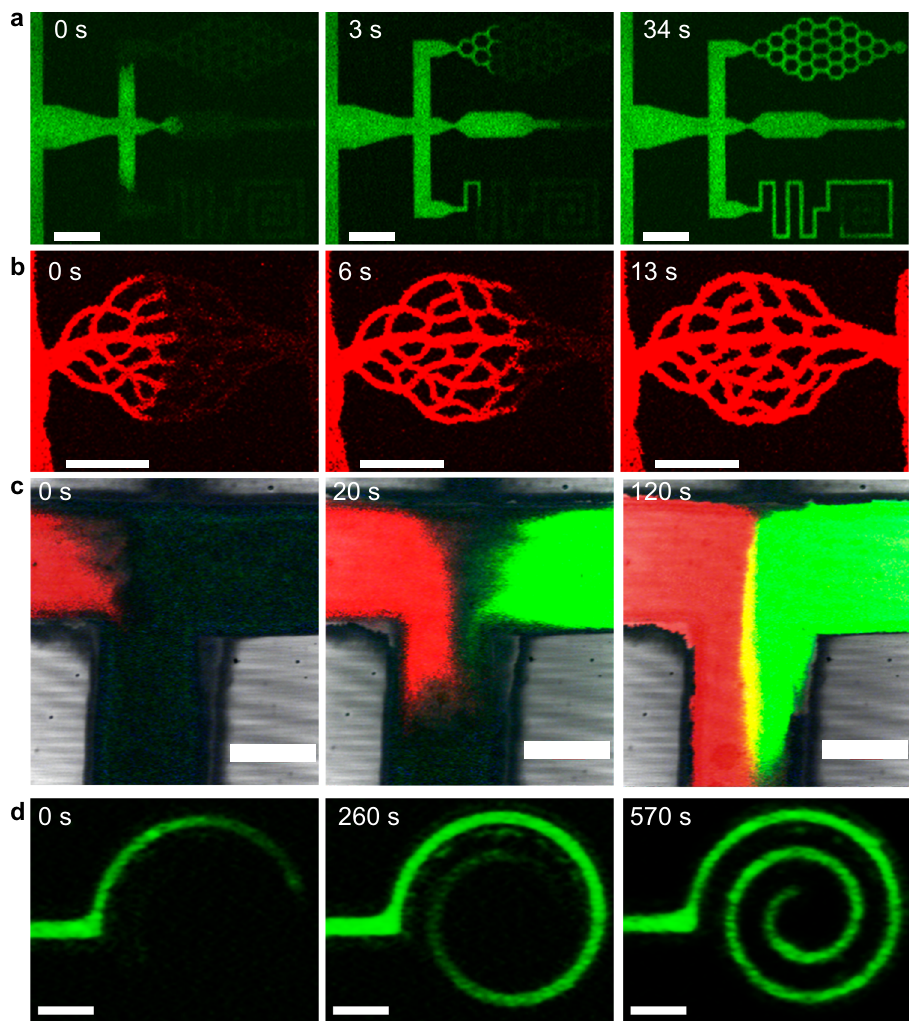
Fig. 2 Confocal laser scanning microscope photos for liquid fl ow in OM channels. Liquid fl ow through ( a ) a complex channel and ( b ) a capillary-like pattern, respectively. c Two stream mixing at a T-junction channel. d Aqueous solution fl ow through a spiral pattern. In ( a – c ), the liquid is ethanol/water (9/1, v/v), and the fl uorescent dyes are ATTO 495 (green) and ATTO 610 (red). In ( d ), the liquid is an acrylamide aqueous solution (5 wt%) and the fl uorescent solute is a green fl uorescent protein. Substrate: ( a , b ), silicon wafer, ( c , d ) cover glass. Scale bar, ( a , b ) 100 μ m, ( c ) 0.5 mm, ( d ) 20 μ